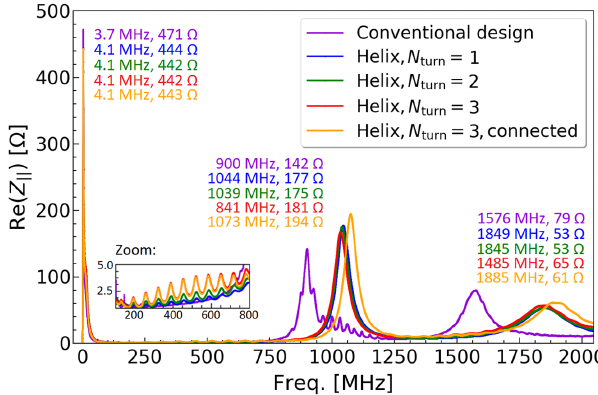
FIG. 10. Real part of the longitudinal impedance of the helical beam screen with a different number of turns, a symmetric ¼ 44 mm and ungraded screen conductors, vacuum gap, L overlap in comparison with the initial design of the conventional beam ¼ 56 mm (simplified screen and L overlap